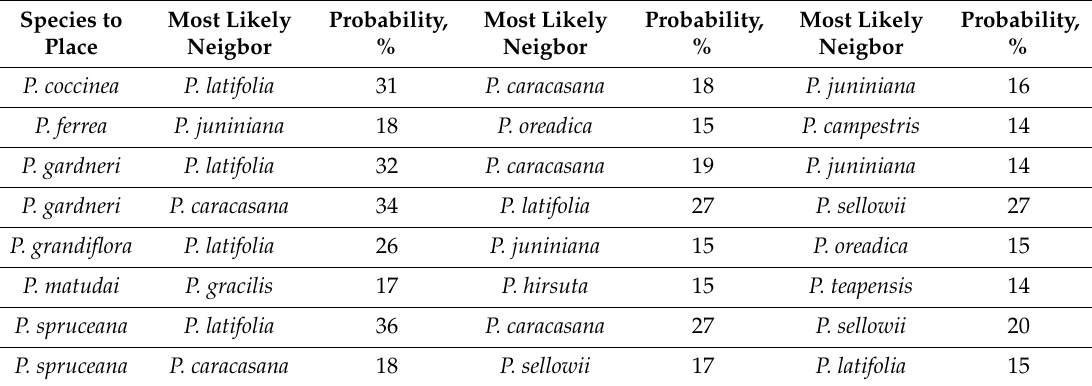
Table 1. Placements of Picramnia species based on k -nearest neighbor machine learning. Species to Most Likely Probability, Most Likely Probability, Most Likely Probability, Place Neigbor % Neigbor % Neigbor